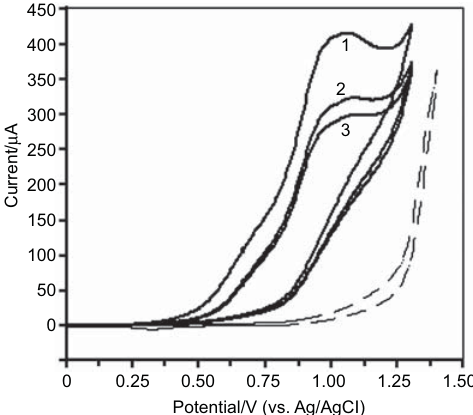
Figure 2 Multisweep cyclic voltammogram in phosphate buffer pH 12.0 in the absence (dashed line) and presence (solid line) of 1.31 m M TU. Scan rate: 100 mV s -1 ; potential range: between 0 and + 1.3 V. The numbers indicate the number of